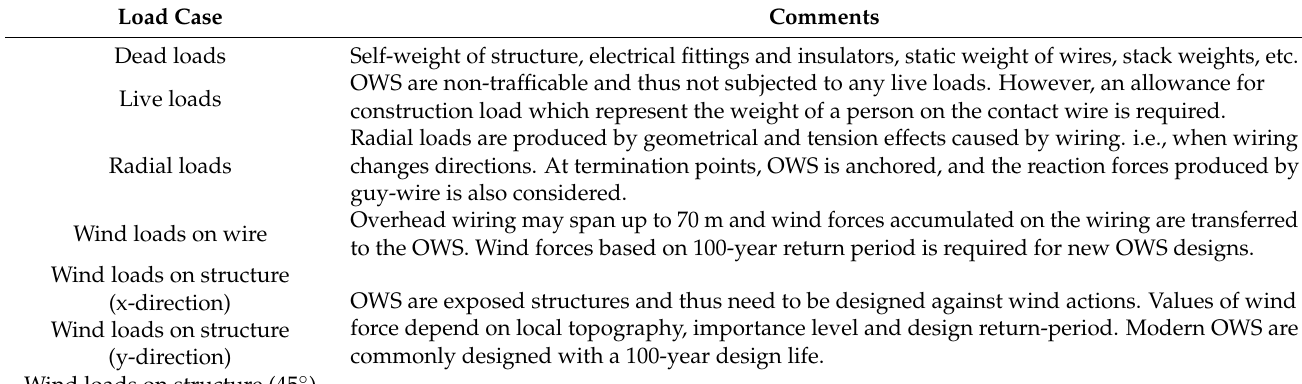
Table 1. Load cases of OWS design.